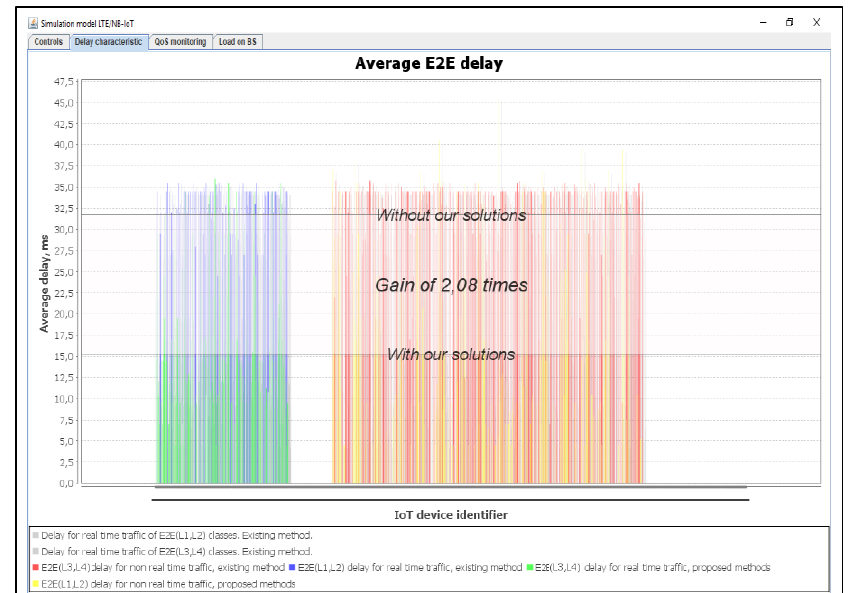
Figure 22. Average E2E delay gain of IoT services for our solution (average load of IoT controller ρ = 75%).